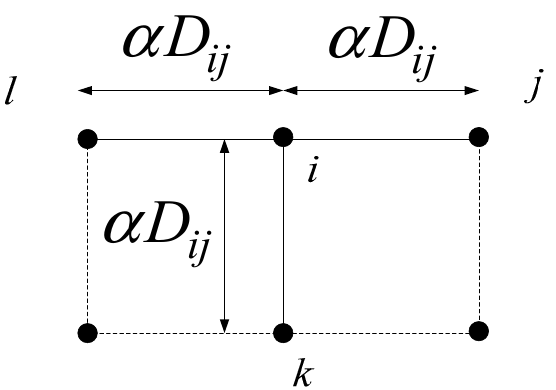
Figure 1. A part of the virtual grid including vertices i, j, k, and l.